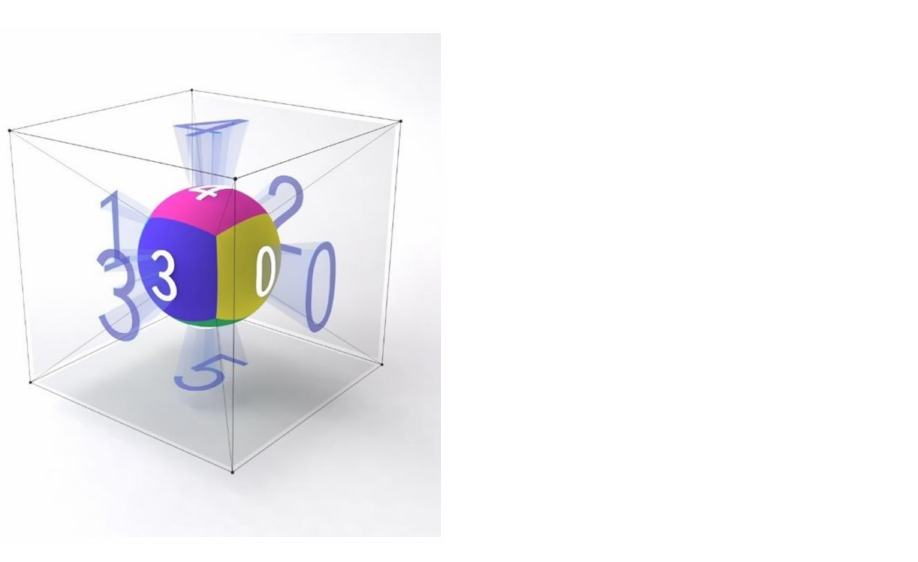
Figure 4. The cube map conversion process reflects the image on each side of the photosphere (represented by the color sphere in the center) to the nearest side of the cube to minimize distortion in the final result of the flattening process [46]. The sphere was divided into six parts and the numbers represented the order of each part of the sphere that reflected the corresponding cube side.